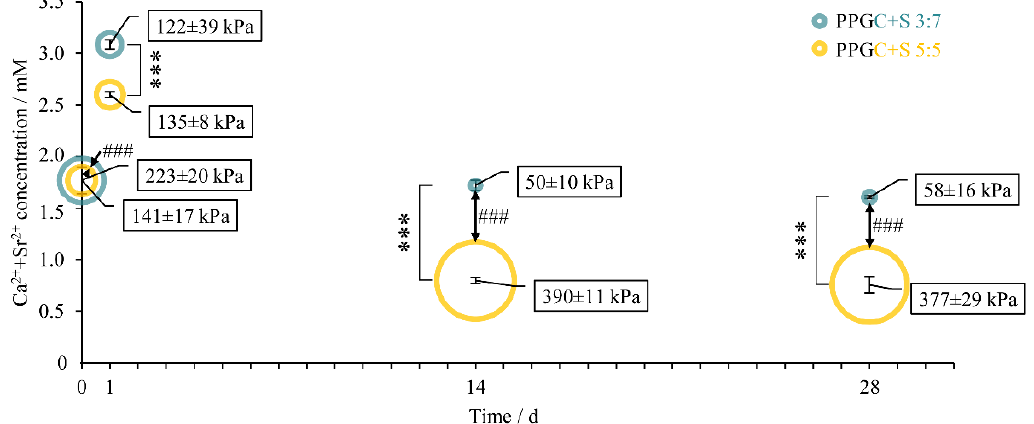
Figure 2. Ion concentrations of calcium and strontium determined colorimetrically over 28 d during static incubation of the specimens in A-minimal essential medium ( α -MEM). Bubble size and data labeling indicate the indirect tensile strength of specimens during incubation. Error bars and ± values indicate standard deviation. Significant differences in ion concentrations and indirect tensile strength are indicated by asterisks and hashes, respectively.